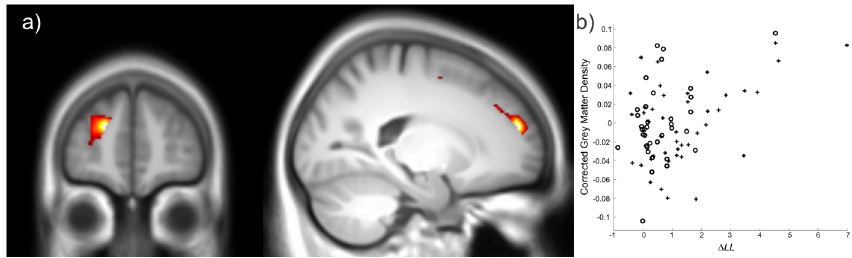
Fig 4. Voxel-based morphometry results for the Δ LL regressor encoding how strongly individual subjects’ behaviour showed evidence for sequential inference. 4a) Δ LL was positivelycorrelatedwith grey matter density in the left anterior prefrontalcortex. (Image thresholdedat p < 0.005, cluster size k > 10, uncorrected for displaypurposes.Slices depictedare at y = 53 (left) and x = -20 (right))4b) Scatter plot showingthat both younger(crosses) and older (circles) subjects showeda similar positive relationship between Δ LL and grey matter density. (Grey matter density extracted from the group level peak [–20 53 20], and corrected for all other regressorsin the design